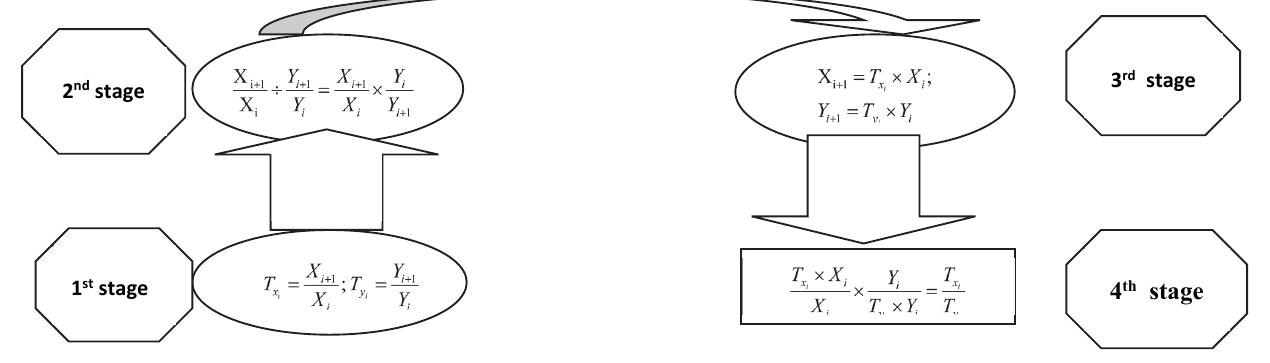
Fig. 1. Algorithm for deriving the formula of the correlation of factors and the resultant indicator of the state of financial security of joint-stock